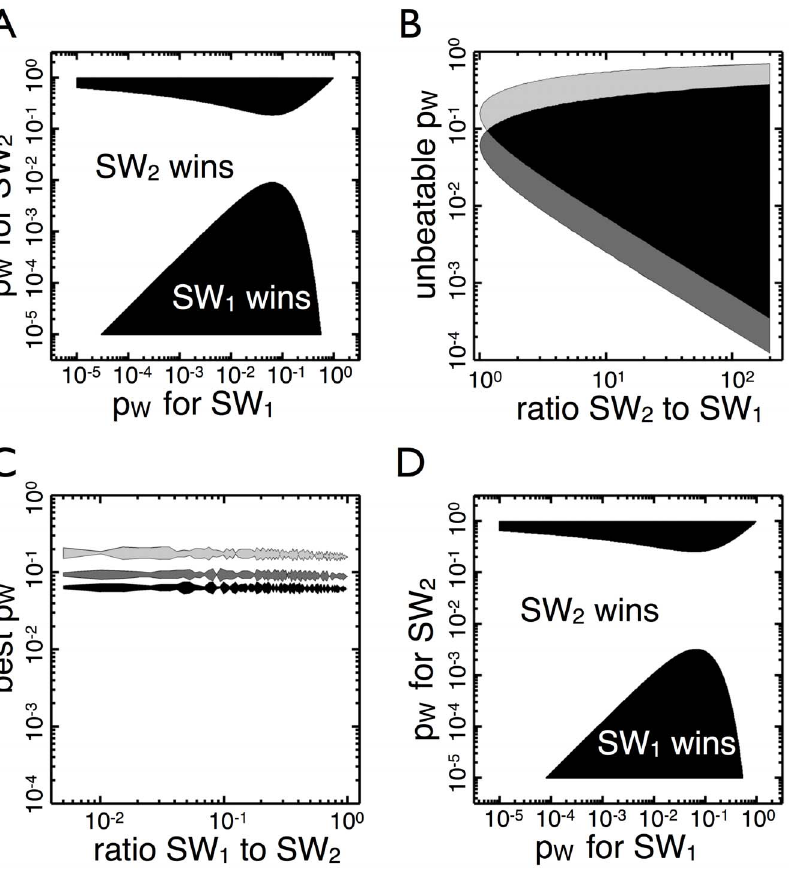
Figure 3. Competitions in which one organism has a numerical or growth advantage. (A) SW 2 begins growth in E S with a 3: 1 advantage to SW 1 (150: 50, growing to N= 10 12 ). The black area corresponds to combinations of p w in which SW 1 leaves more W types than SW 2 (white is the converse). The gap between the two areas corresponds to a range of transition probabilities in which SW 2 maintains an advantage independent of the transition probability of SW 1 . (B) The range of transition probabilities for which SW 2 maintains an advantage is shown as a function of the initial numbers advantage. The light gray area corresponds to N ~ 10 6 , the dark gray is N ~ 10 12 , and black is the overlap. Increased carrying capacity (N) shifts the range of transition probabilities down but does not greatly alter the total area. (C) The transition probability p w that minimizes the losses for SW 1 is shown as a function of its numerical disadvantage. The light gray is N ~ 10 6 , the dark gray is N ~ 10 9 , and the black is N ~ 10 12 . There is a slight increase in the optimal transition probability as the disadvantage increases (left of the graph) but it is less than a tenth of an order of magnitude away from the optimal transition probability when the competition is fair. (D) SW 2 has a growth advantage compared to SW 1 , dividing 10% faster. The two begin with one organism and divide until N ~ 10 10 . Again SW 2 has a range of unbeatable transition probabilities, and the graph resembles A. (Figure 4c). As the growth rate of the W types approaches half that of the S types, the optimal transition probability is the same as when the W types do not grow at all. The insensitivity of the optimal transition probability to the growth rate of the maladapted type is independent of N , the population size at which the environment transitions. Thus, as long as there is a growth disparity between the two phenotypes, there is selective pressure to stably produce both types at high frequency.